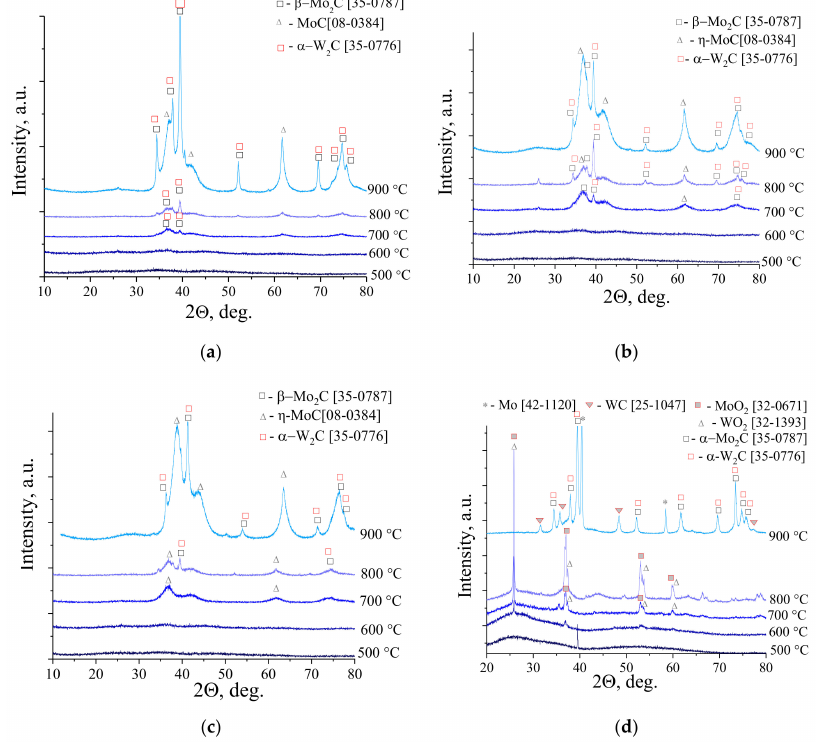
Figure 3. XRD patterns of molybdenum-tungsten blue xerogels collected in the function of temperature forthesamplescalcinedatmaximum900 ◦ Cininertatmospherewithdi ff erentratios: ( a )[Mo] / [W] = 95 / 5; ( b ) [Mo] / [W] = 90 / 10; ( c ) [Mo] / [W] = 80 / 20; ( d ) [Mo] / [W] = 50 / 50 ([R] / [ Σ Me] =